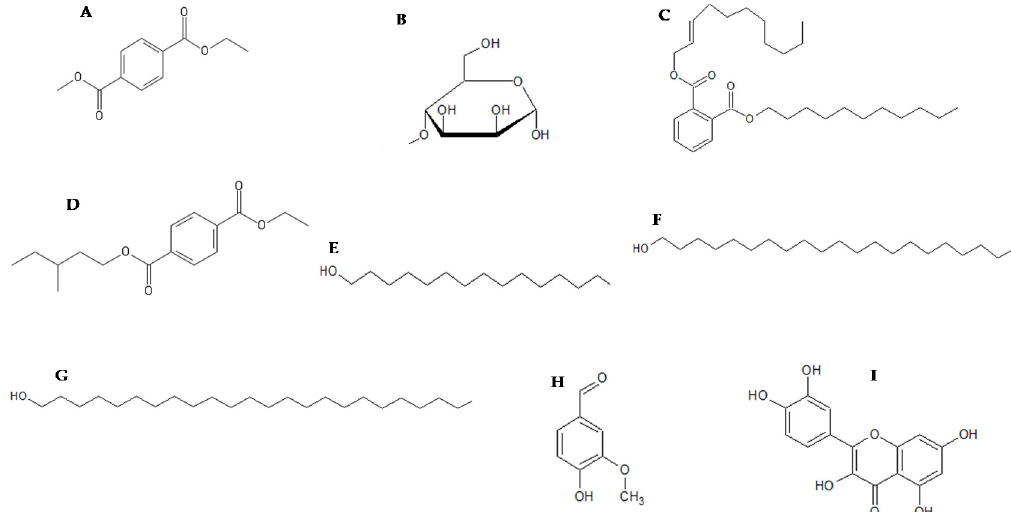
Figure 4. 2-dimensional structures of the compounds identified from the Calpurnia aurea extract used in molecular docking against the Chromobacterium violacein CviR protein. ( A ) = Dimethyl terephthalate, ( B ) = Methyl mannose, ( C ) = Phthalic acid undecene-undecyl ester, ( D ) = Teraphthalic acid, ethyl isobutyl ester, ( E ) = Pentadecanol, ( F ) = Eicosanol, ( G ) = Tetracosanol, ( H ) = Vanillin, and ( I ) = Quercetin. Vanillin and quercetin served as positive anti-quorum sensing (AQS) controls.